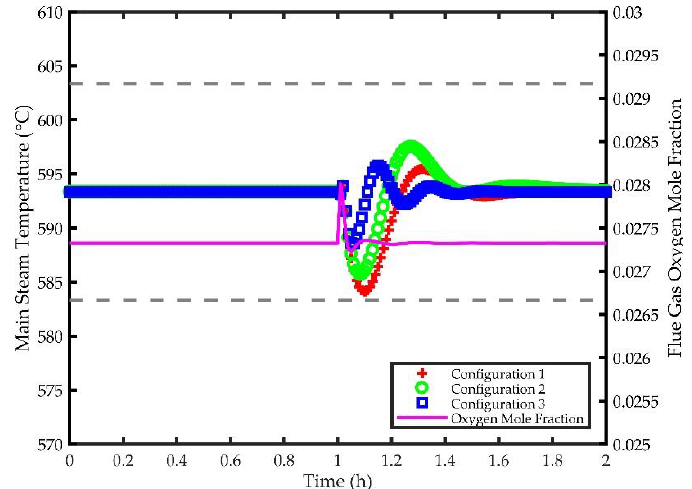
Figure 17. Disturbance Rejection Results for Main Steam Temperature and Flue Gas Oxygen Concentration.